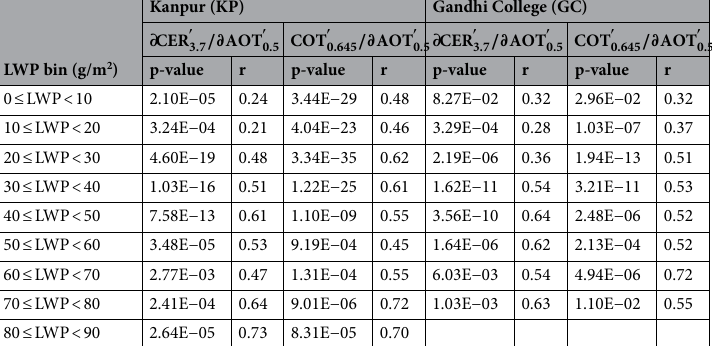
Table 1. Results of p-value and correlation coefficient (r) value for regression models used to determine ′ AOT ′ COT ′ AOT ′ ∂ CER 0.5 and ∂ 0.645 /∂ 0.5 for Kanpur (KP) and Gandhi College (GC) shown in Fig. 3.7 /∂